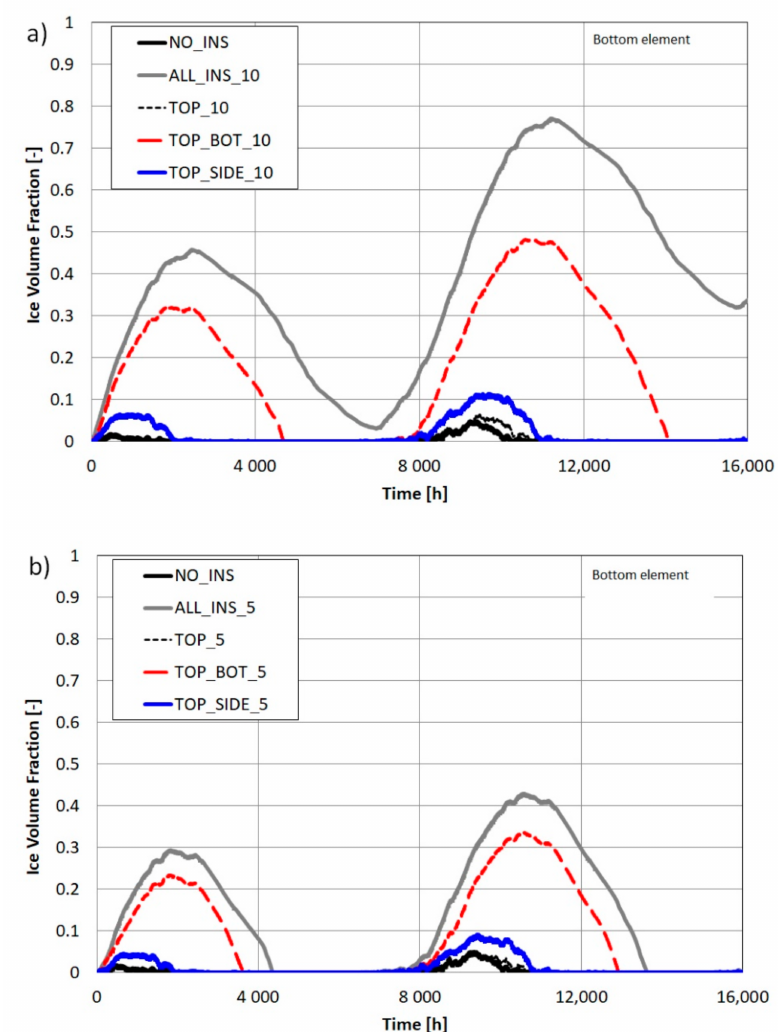
Figure 10. Ice volume fraction of the bottom element of the IT: ( a ) 10-cm cases; ( b ) 5-cm